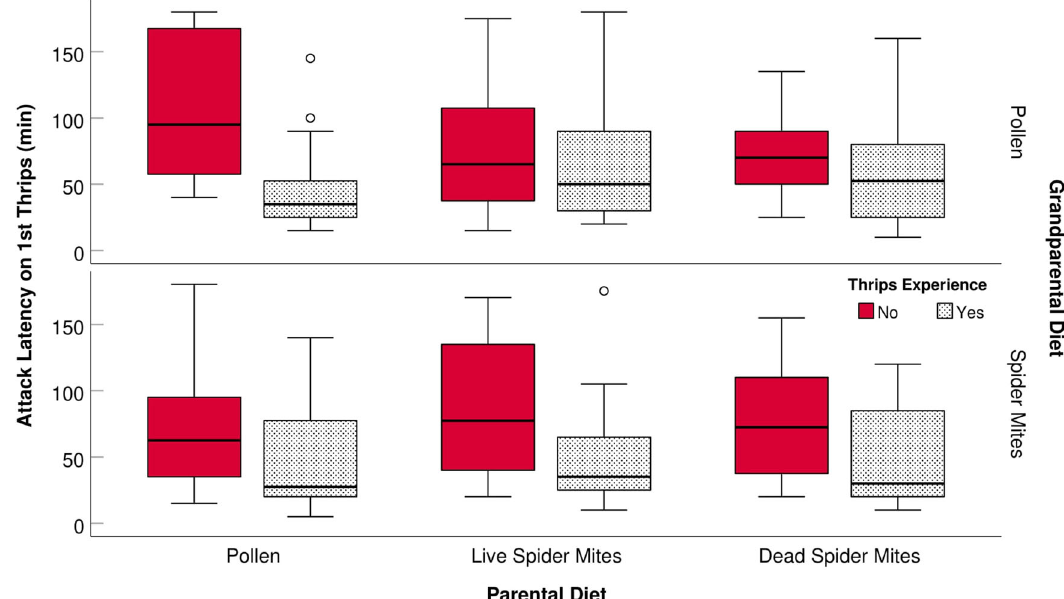
Fig. 2 Latency to attack the fi rst prey individual. Latency (min; mean ± SE) of single mated A. swirskii females to attack and kill the 1st out of three 1st instar thrips, F. occidentalis , presented inside acrylic cages within 3 h. Predatory mite females had experienced thrips early in life or not ( + or − ) and were the progeny of parents fed Typha pollen (P), life spider mites (L), or dead spider mites (D), and grandparents fed Typha pollen (P) or live spider mites (L). The numbers of replicates ( n ; independent experimental animals) within treatments (sequence in treatment acronyms is grandparental diet, parental diet, early life experience by progeny) are 20 (LP + ), 20 (LP − ), 18 (LL + ), 14 (LL − ), 17 (LD + ), 20 (LD − ), 15 (PP + ), 16 (PP − ), 21 (PL + ), 16 (PL − ), 14 (PD + ), 15 (PD − ). Boxes represent the 1st and 3rd quartile, the thick horizontal line inside boxes is the median, whiskers show the minimum and maximum values, symbols depict the outliers. Grandparental diet and thrips experience had signi fi cant effects (GLM, P < 0.05; see Table 1 for complete statistical results).